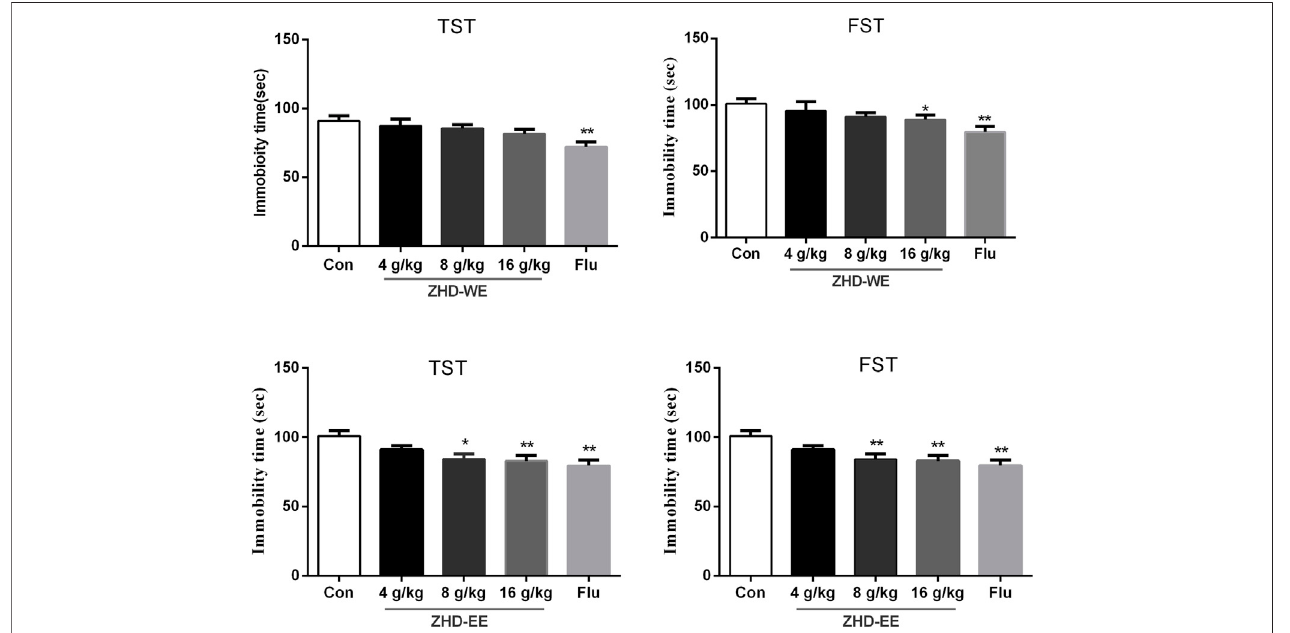
FIGURE1| EffectsofZHD-WEandZHD-EEontheimmobilitytimeintailsuspensiontestandforcedswimmingtest.Thedataarepresentedasthemean±SD( n= 10). ZHD-WE, water extract of ZHD; ZHD-EE, ethanol extract of ZHD.